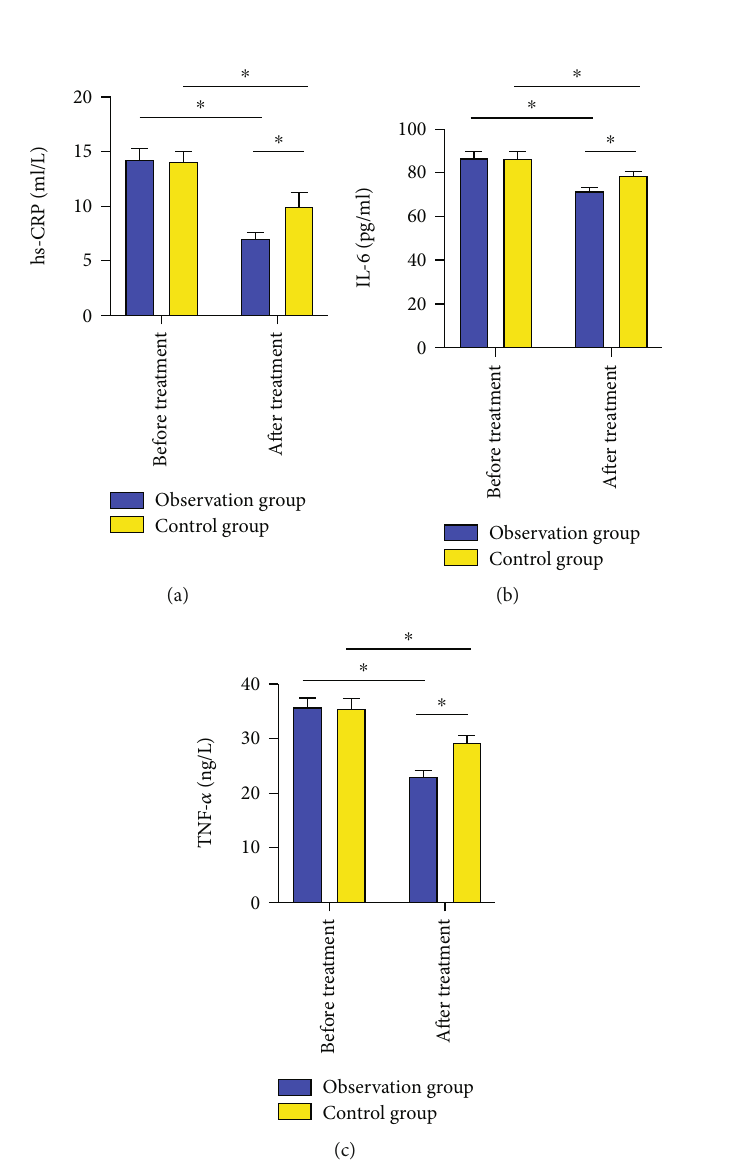
Figure 1: Comparison of serum in fl ammatory factors between two groups: (a) comparison of serum hs-CRP between two groups of patients; (b) comparison of serum IL-6 between two groups of patients; (c) comparison of serum TNF- α between two groups of patients. ∗ P < 0 : 05